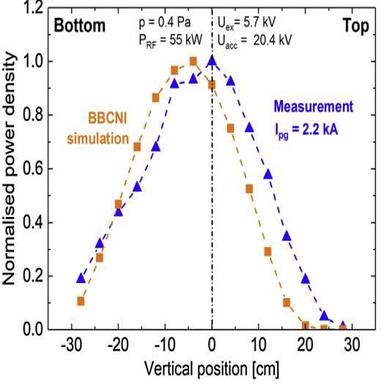
Beam profile measured with the thermocouples in the calorimeter compared with BBCNI simulation for the magnetic field created by the PG current.